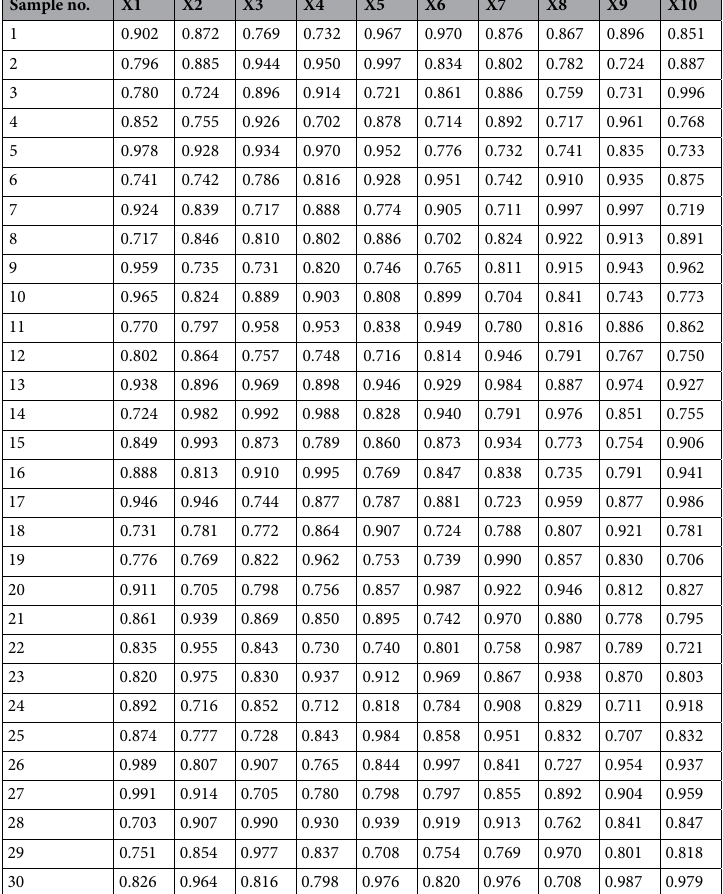
Table 2. Sample points for Latin hypercube